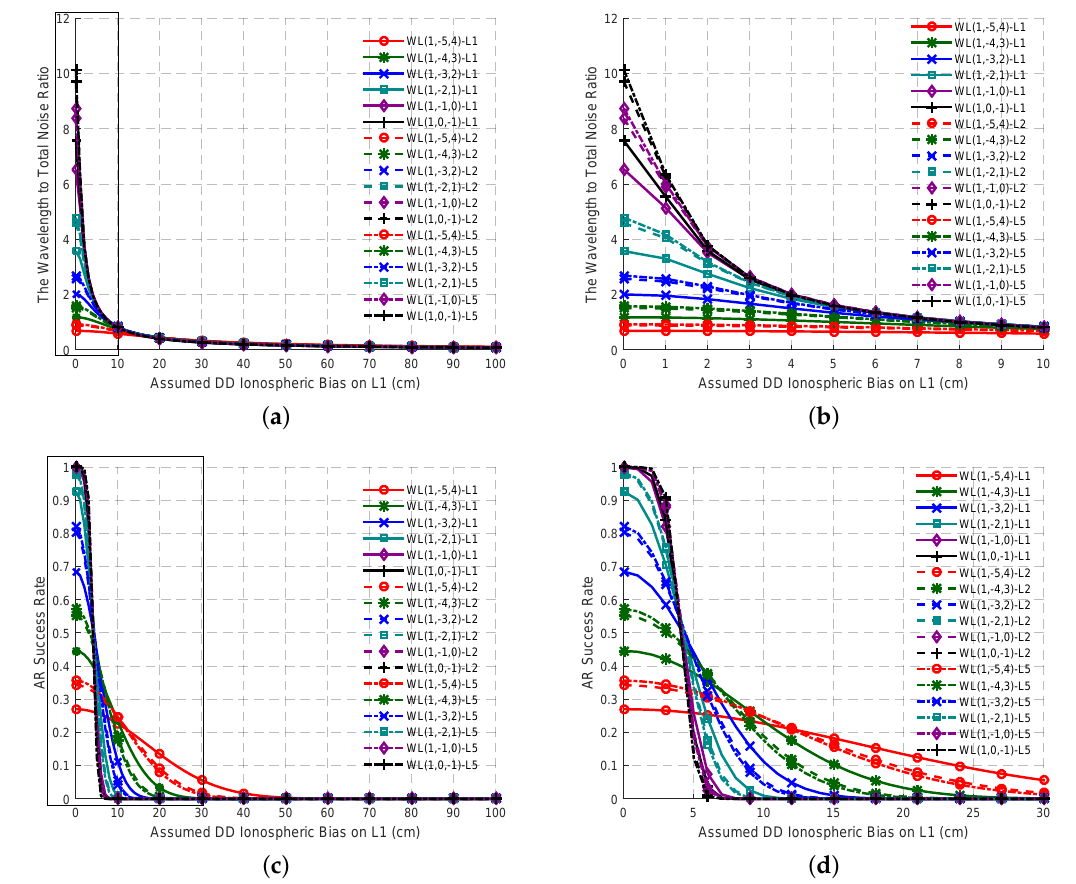
Figure 5. The variation trend of the wavelength to total noise ratio and the AR success rates of the signal pairs of GF TCAR in Table 4 updates with the DD ionospheric bias on L1. ( a ) The wavelength to total noise ratio; ( c ) AR success rate; ( b , d ) are the amplification of the rectangle in ( a , c )